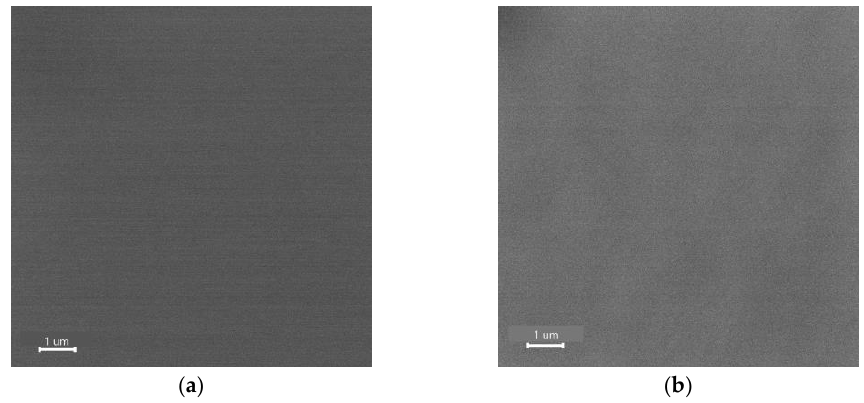
Figure 1. Scanning electron microscope (SEM) view of the surface of ( a ) InSe and ( b ) Sb 2 Se 3 .